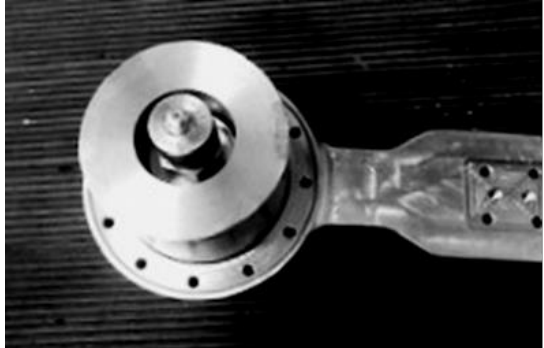
Figure 5. The sample with additional mass of 0.620 kg.